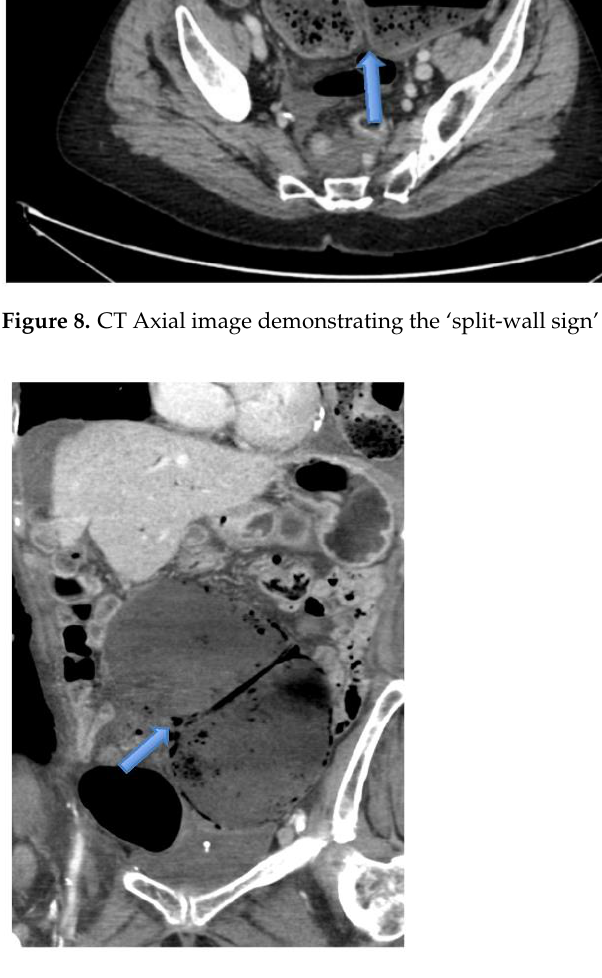
Figure 9. CT coronal image demonstrating the split-wall sign (blue arrow) which refers to the mes- enteric fat in between the bowel walls.